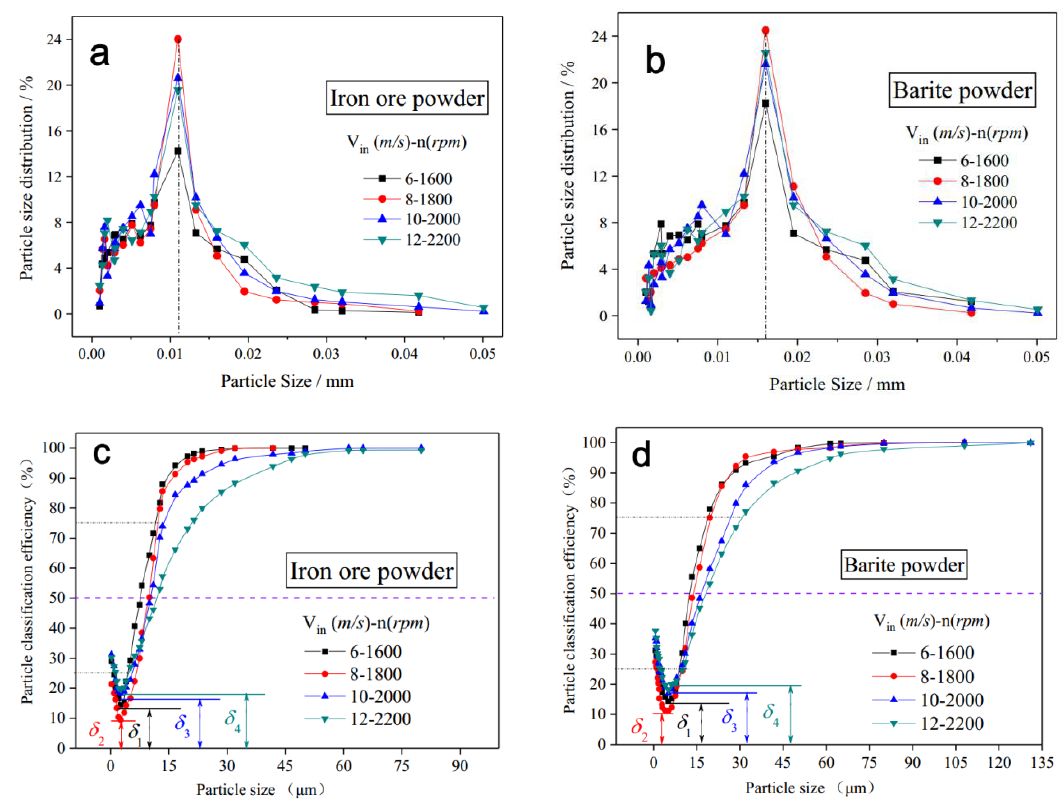
Figure 7. The particle size distribution and the classification efficiency of two different materials. ( a ) Iron ore powder experiments distribution curves ( b ) Barite powder experiments distribution curves ( c ) Iron ore powder experiments Tromp curves ( d ) Barite powder experiments Tromp curves